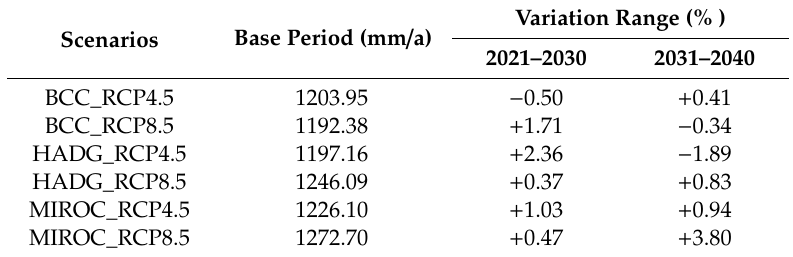
Table 3. The variation ranges of the estimated evapotranspiration data in 2021–2040. Scenarios Base Period (mm /